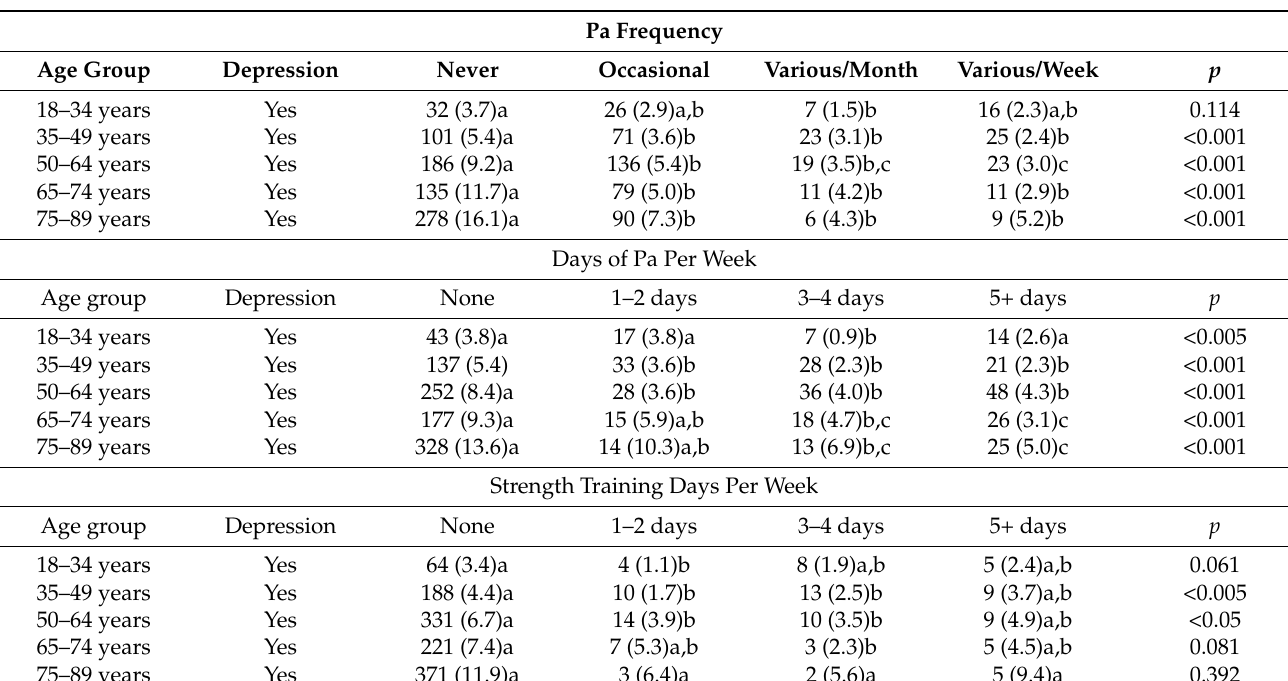
Table 5. Relationship between the frequency of PA. Days week of PA and muscle strengthening and some type of diagnosed depression, according to phq8 in the Spanish population by age